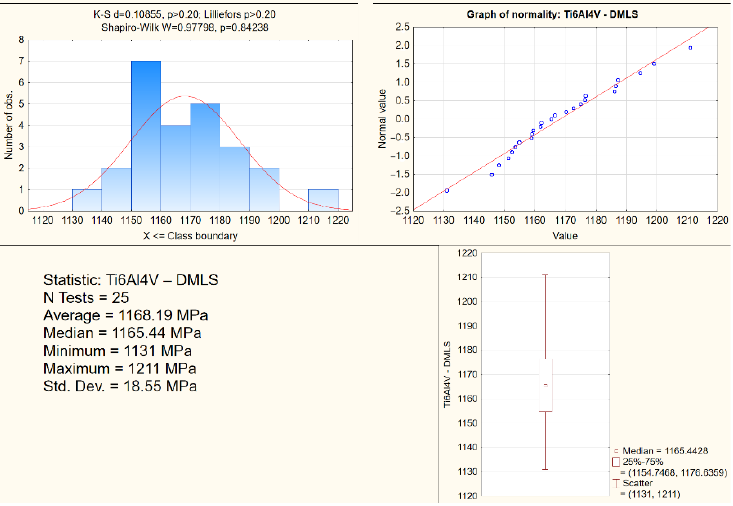
Figure 8. An exemplary analysis of the normality of the offset yield stress distribution in compression tests for Ti6Al4V from DMLS.